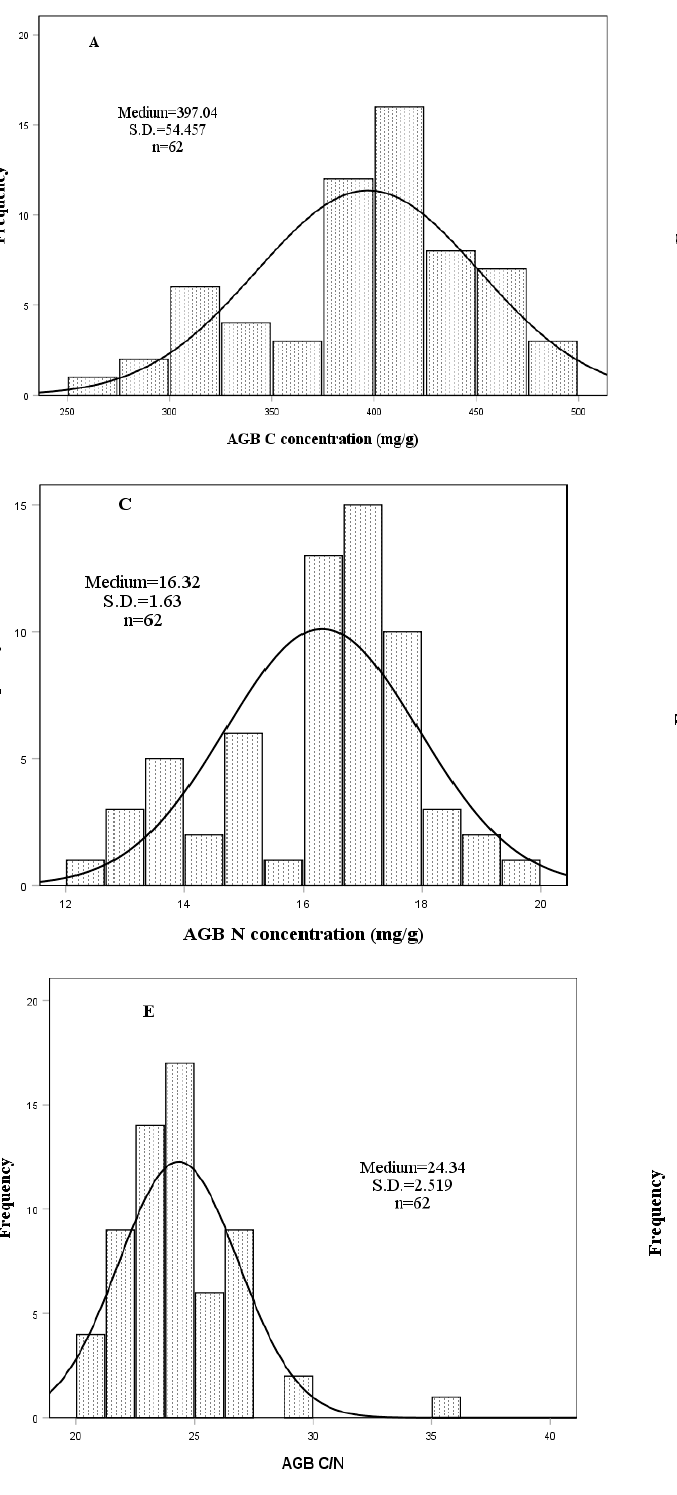
Figure 3. The frequency distribution of C, N concentrations and C/N of belowground biomass (BGB) and aboveground biomass (AGB) in 5 alpine grassland types. ( A ): alpine meadow (AM), ( B ): alpine steppe (AS), ( C ): alpine meadow steppe (AMS), ( D ): alpine desert steppe (ADS), ( E ): alpine desert (AD) and ( F ): alpine grassland types.